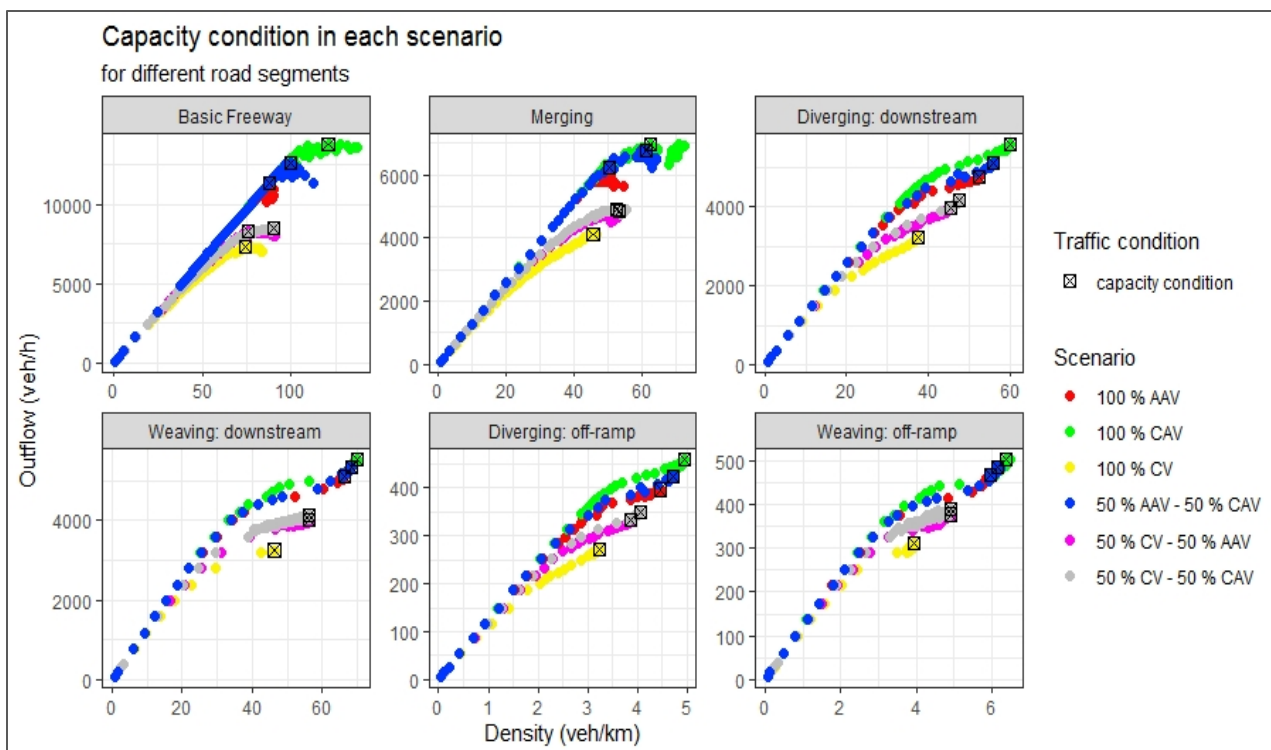
Figure 3. Capacity condition in each scenario for different road segments.